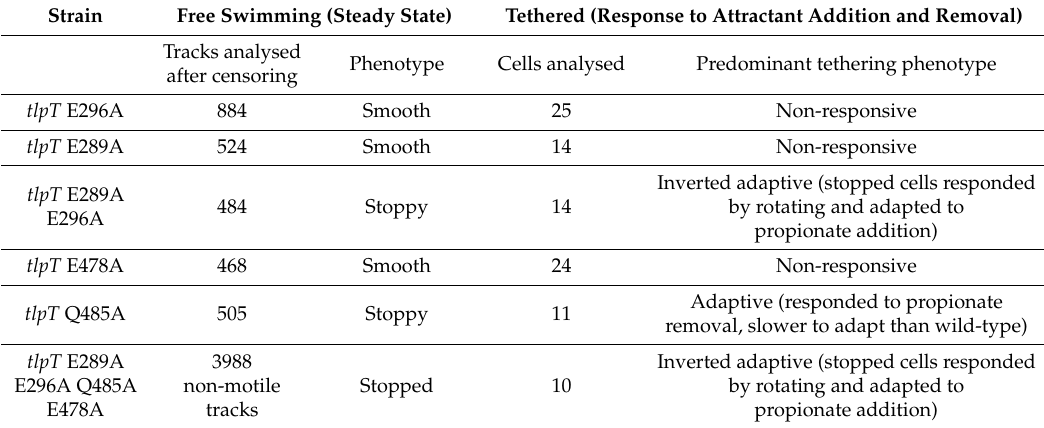
Table 3. Free swimming and tethering phenotypes for TlpT methylation site